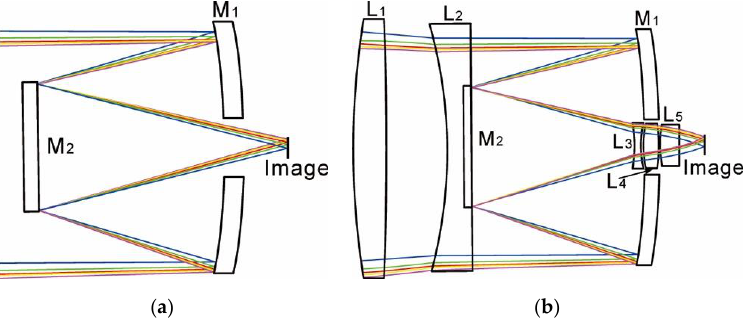
Figure 2. Schematic diagrams of ( a ) initial optical system structure, ( b ) optimized optical system structure.